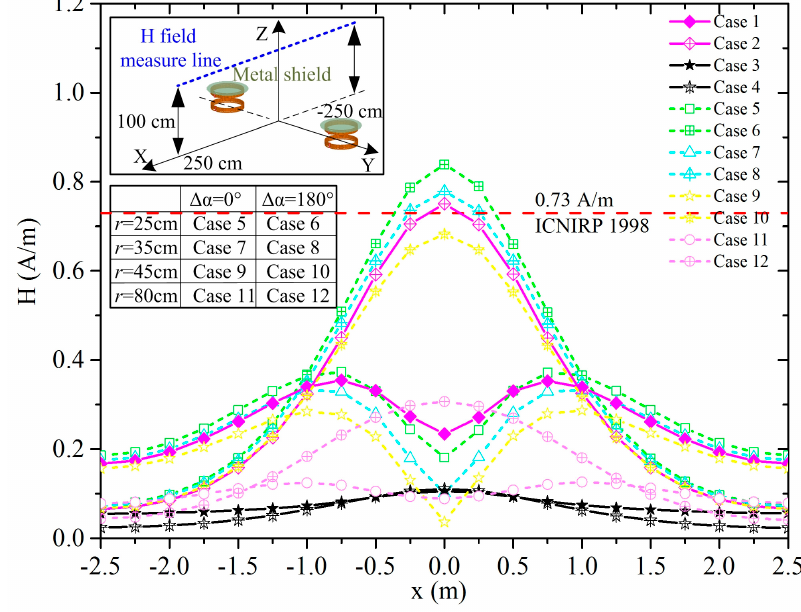
Figure 7. Magnetic field intensity (A/m) of two parallel WPT systems with a metal shield along the measure line in illustration.